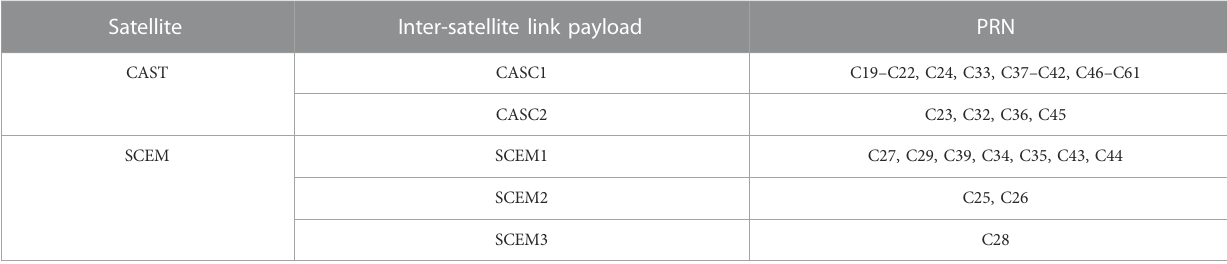
TABLE 3 Information about the manufacturer of satellite and inter-satellite link